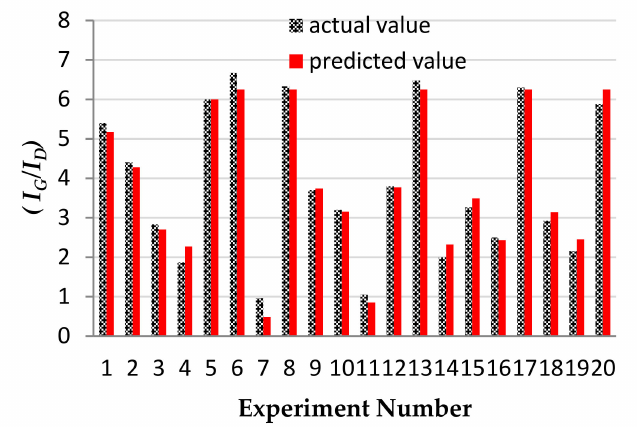
Figure 6. Experimental and theoretically predicted values for Raman spectroscopy